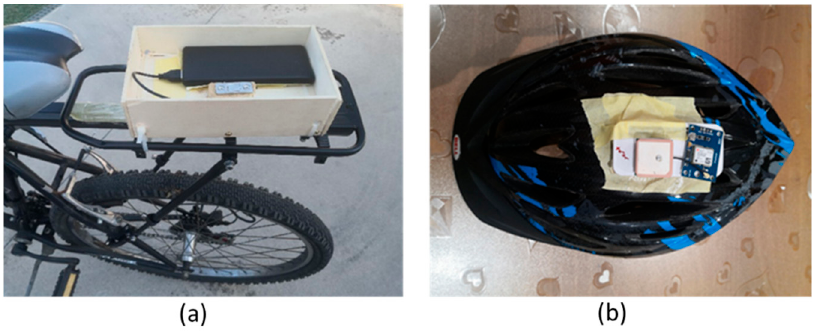
Figure 14. Installation of the prototypes on the bike: ( a ) Bike-frame and ( b ) Bike-helmet